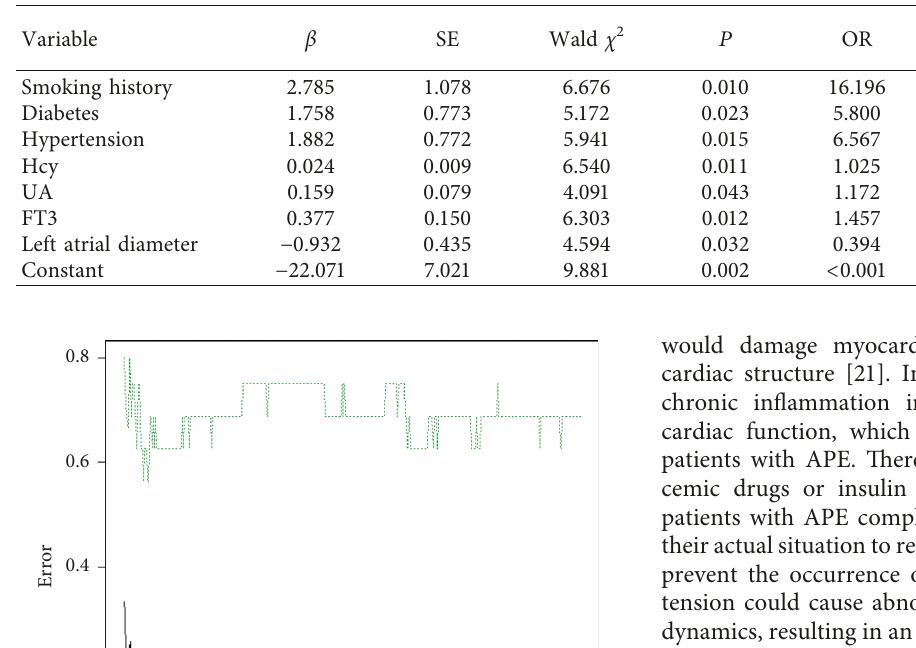
Table 3: Multivariate logistic regression analysis of APE patients complicated with